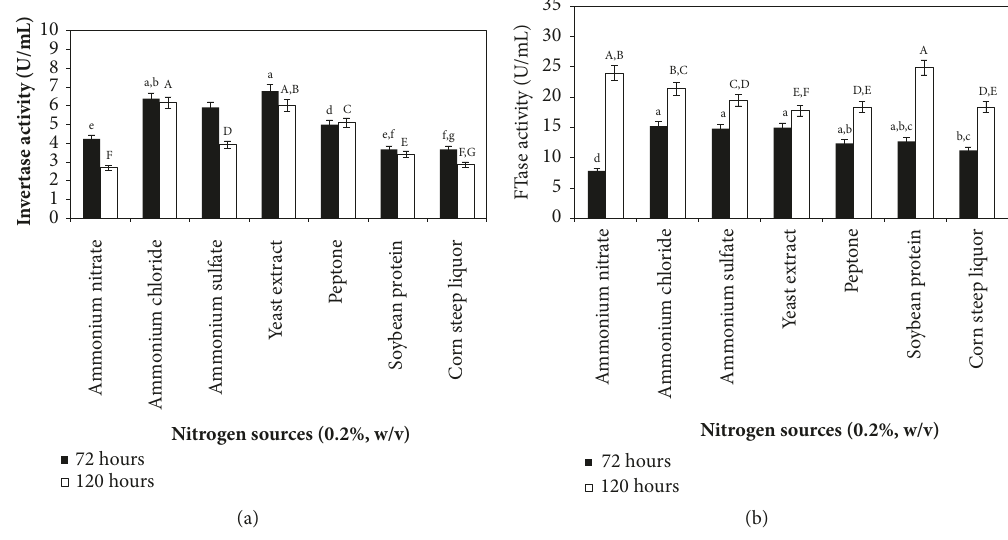
Figure 4: Organic and inorganic nitrogen sources on invertase (a) and 𝛽 -D-fructosyltransferase (b) production by A. carbonarius PC-4. Culture conditions: pineapple crown (1.0%, w/v), nitrogen sources (0.2% w/v), 28 ∘ C, 180 rpm. Mean values with the same letter do not statistically differ from each other by the ANOVA Tukey test (p =